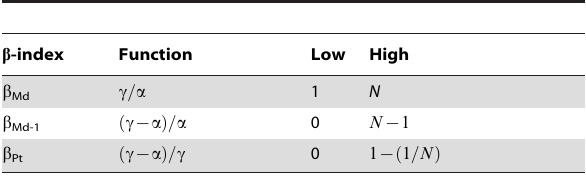
Table 1. Mathematical definitions and expressions of beta- diversity indices.